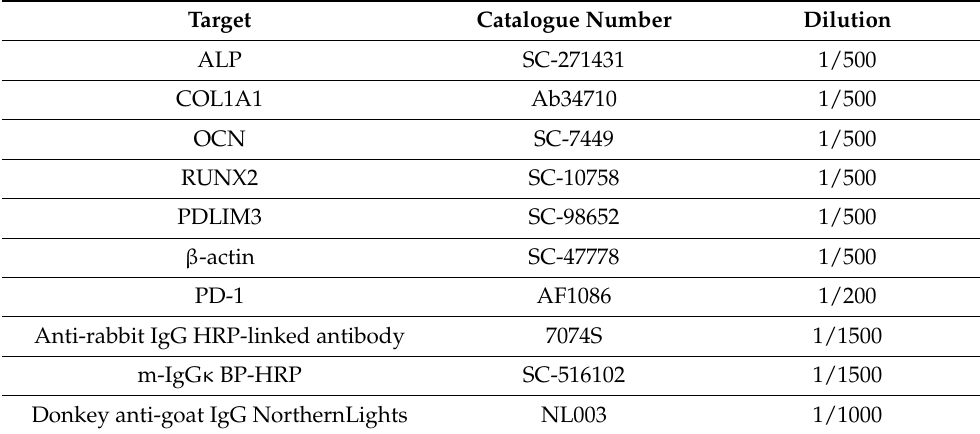
Table 2. List of antibodies used in the